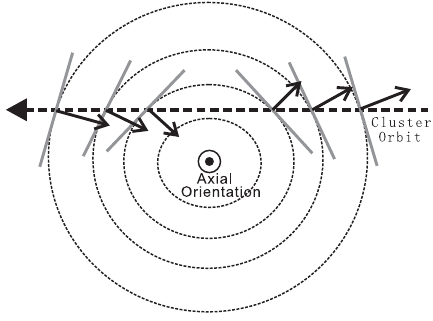
Fig. 1. Sketch of the Cluster constellation traversing a 2-D structure. The set of magnetic contour planes are represented by the dashed circles and the normal directions of these planes are the solid ar- rows. All of these arrows are shown to be perpendicular to the axial orientation of the 2-D